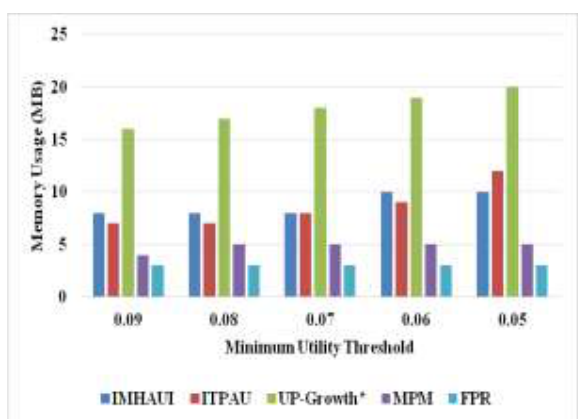
Figure 9. Liver_Disorders Memory Usage